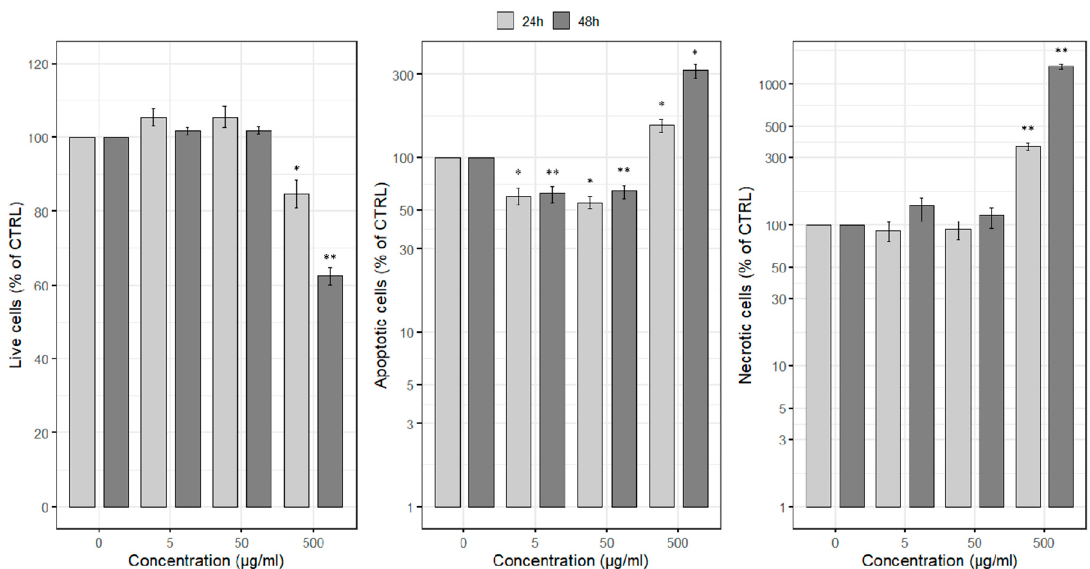
Figure 3. F. sellowiana acetonic extract induced apoptosis on SNU-1 cells. Cells (2.5 × 10 5 ) were treated with increasing concentrations of F. sellowiana extract for 24 and 48 h. The amount of apoptotic cells was determined by flow cytometry. The apoptosis rate was estimated in comparison to the untreated cell. Data were presented as mean and standard error of three individual experiments and were analyzed with a one-sample t -test. * p < 0.05 and ** p < 0.001.